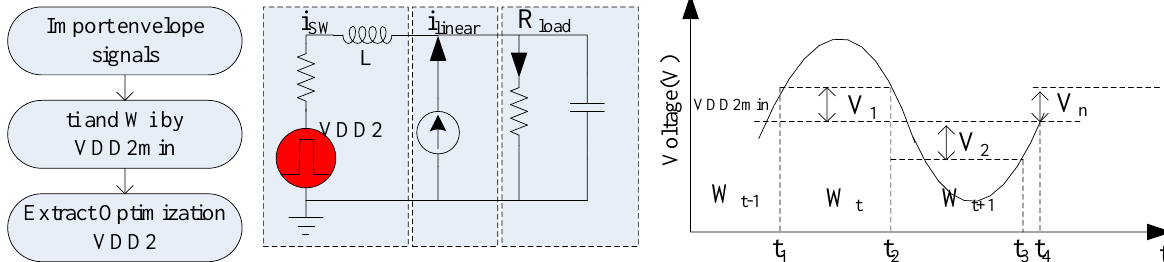
Figure 10. Procedure and simplified circuit model of a hybrid power supply modulator.